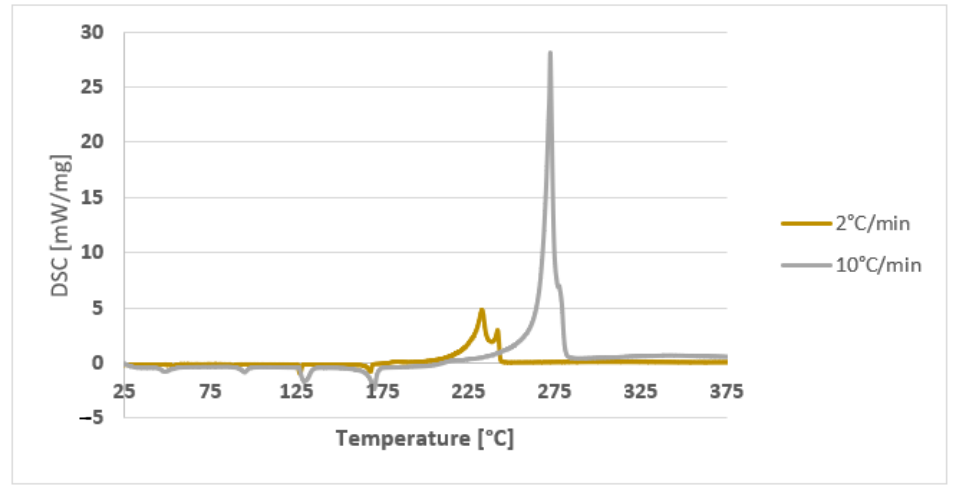
Figure 5. DSC analysis of AN and PE mixture (containing 20% of the polymer) for different heat rates.